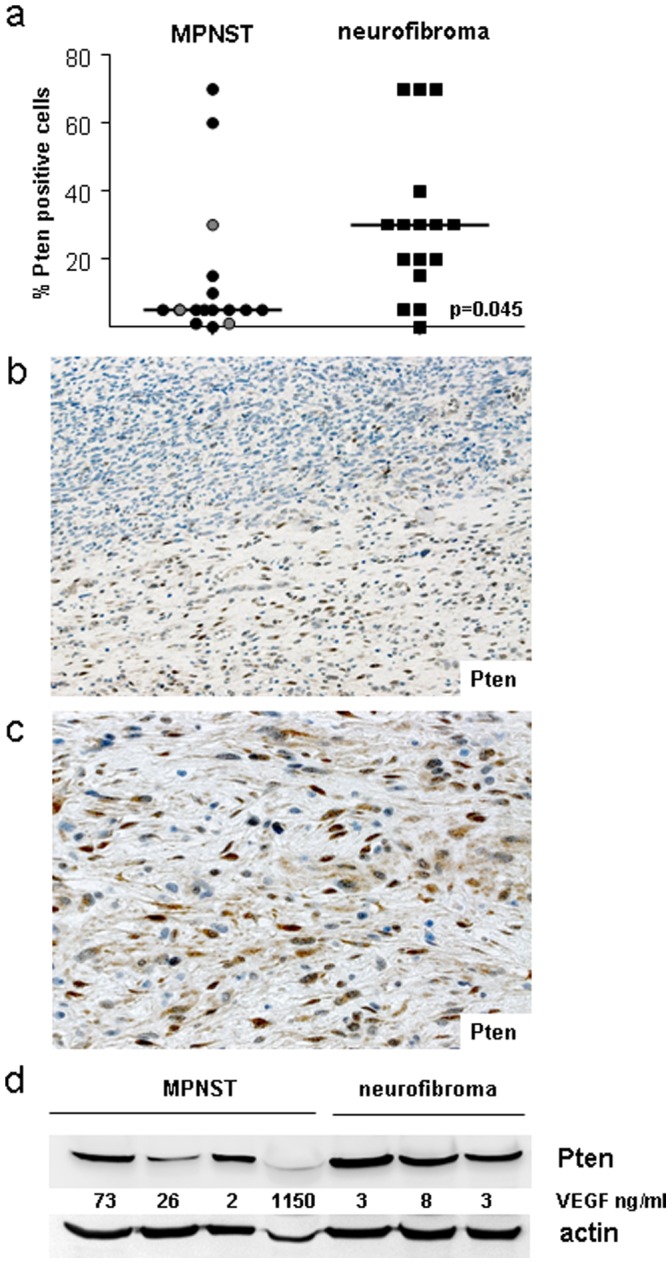
Pten expression in MPNST and neurofibroma.a) Proportion of Pten-positive tumour cells as determined by immunohistochemistry. Each dot represents one tumour. Sporadic MPNST are depicted in grey b) MPNST 29250 with a transition to pNF. Note stronger Pten expression in the pNF (lower part). c) Higher magnification of pNF. Original magnification 200x and 400x. d) Western blot of MPNST and neurofibromas. VEGF concentrations in tumour lysates are indicated.